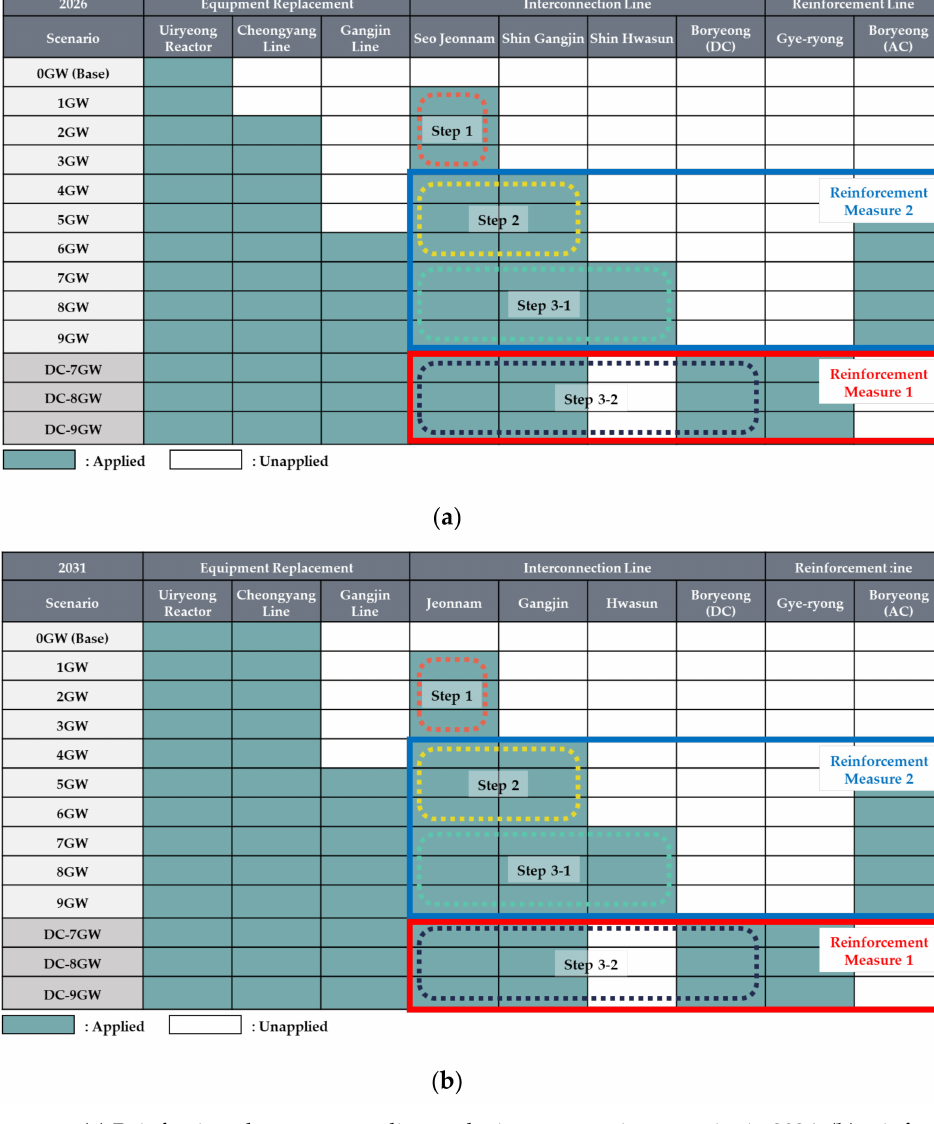
Figure 15. ( a ) Reinforcing elements according to the interconnection capacity in 2026; ( b ) reinforcing elements according to the interconnection capacity in